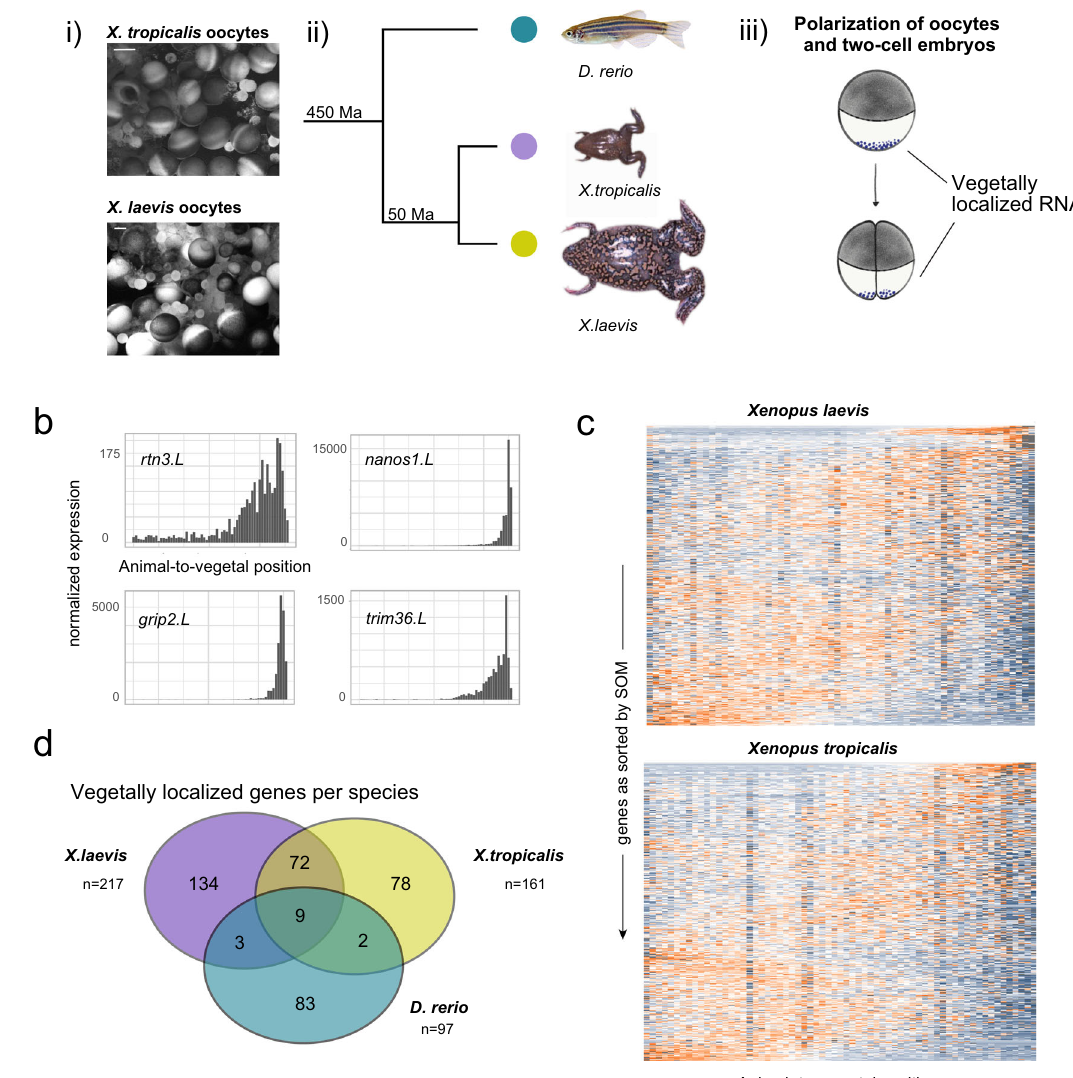
Fig. 5 Evolutionary conservation of vegetal mRNA localization. a (i) Light microscopy view of whole oocyte lobes from X. laevis and X. tropicalis before dissociation for one of the two replicates. Scale bar are 500 µ m. (ii) Phylogenetic distance of Xenopus species and zebra fi sh as described in ref. 74 (Ma: million years). (iii) Deposition of germ plasm and dorsal factors (as purple dots) in Xenopus oocytes and after fi rst cell division. b Tomo-seq tracks of vegetally localized genes rtn3.L , nanos1.L , grip2.L , and trim36.L in X. laevis . c Heatmap of z -score normalized expression per section in Xenopus oocytes. Genes on the y -axis as sorted into pro fi les 1 – 50 by SOM (self-organizing map), spatial position on the x -axis. d Overlap of vegetally localized genes in zebra fi sh and Xenopus species, considering only genes that were expressed in all three species at the respective developmental zebra fi sh use the vegetal pole to store factors for germ cell spe- ci fi cation and dorsoventral axis determination 41,42 , which addi- tionally suggests functional similarity despite a considerable evolutionary distance (Fig. 5a). However, it is important to point out that there are major structural differences between zebra fi sh and Xenopus embryos: zebra fi sh have one big yolk cell, with all blastomeres positioned at the animal pole. In contrast to this, the yolk cell is subdivided during cell division in Xenopus . Since existing Xenopus datasets are derived from pooled samples and do not provide a comparable spatial resolution 43 – 45 , we decided to produce tomo-seq datasets of mature oocytes from X. tropicalis and X. laevis , with two replicates for each species (10 µm resolution for X. tropicalis , and 16 and 18 µm resolution for X. laevis ).